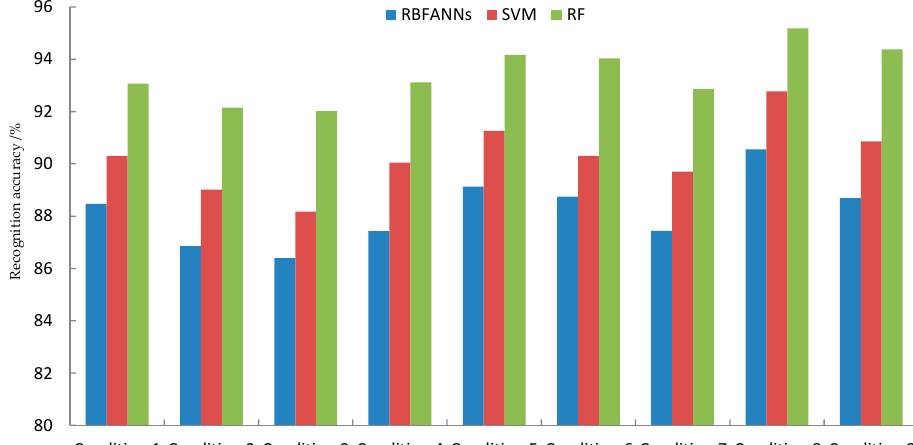
Figure 11. The predicted recognition accuracy under different conditions with different classifiers. RBFANNs: radial basis function artificial neural networks, SVM: support vector machines, and RF: